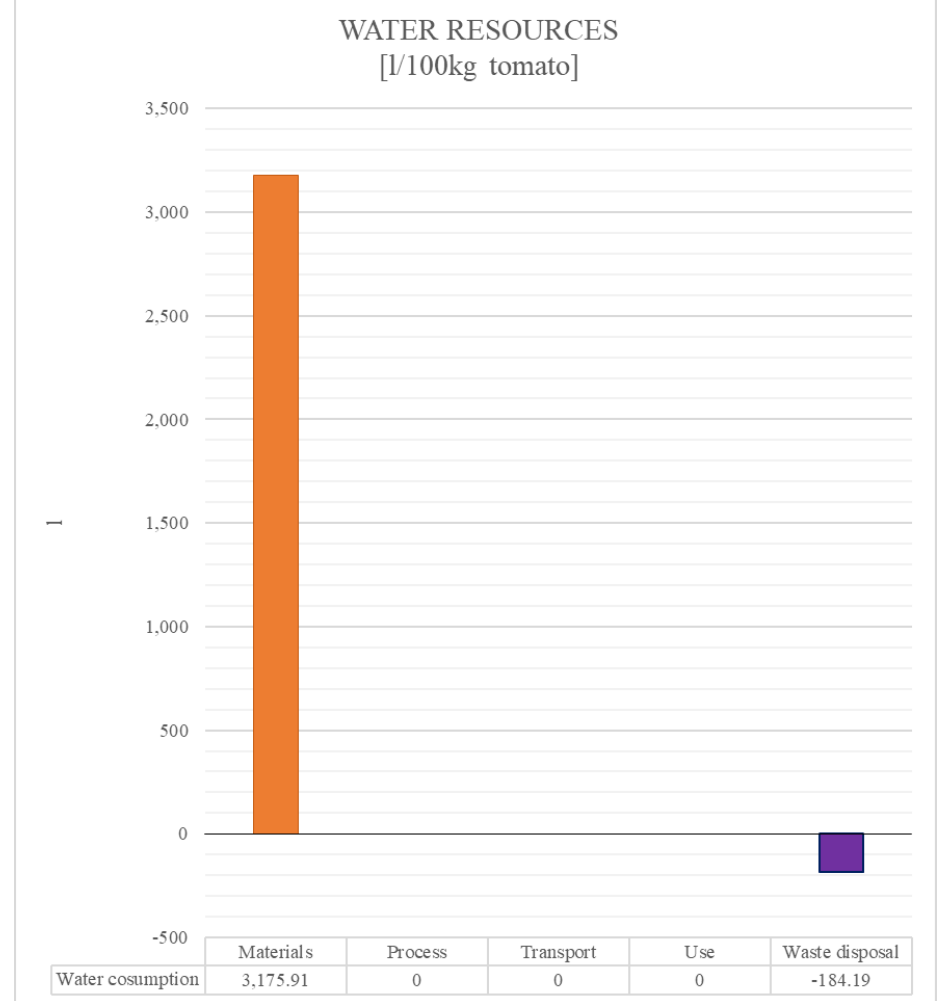
Figure 5. Water consumption of 100 kg of greenhouse tomatoes per life cycle stage (in L). There is no consumption of water during the packaging and processing of the plants other than the water needs for hygiene purposes of the facilities and the workers, which has not been considered here. The transportation stage does not need water, again, other than the cleaning and maintenance of vehicles, which is not considered, either. Finally, the use of tomatoes for final consumption needs a very small amount of water for rinsing, which is virtually impossible to calculate, as it largely depends on individual practices. Discarded tomatoes do not need